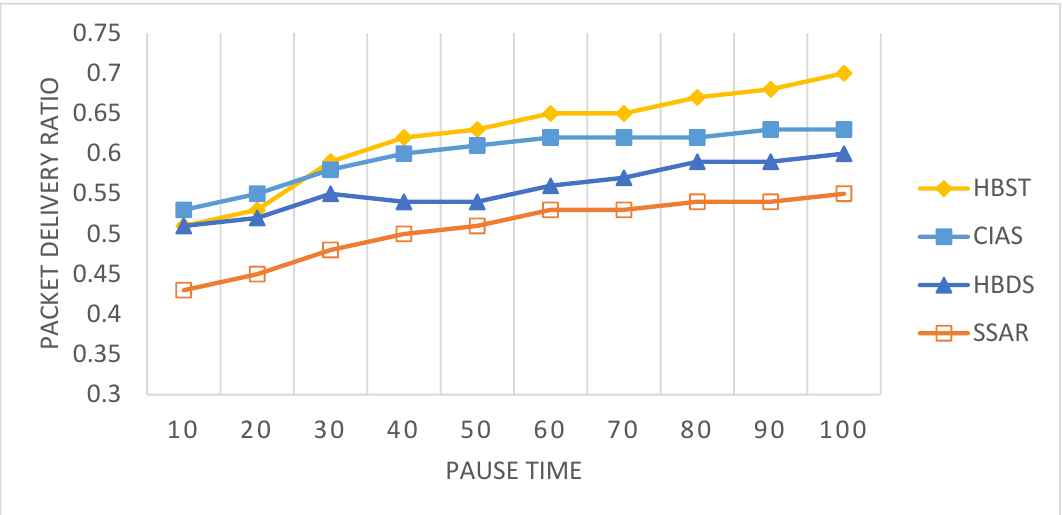
Figure 4. Packet delivery ratio for the network having 25% selfish nodes.